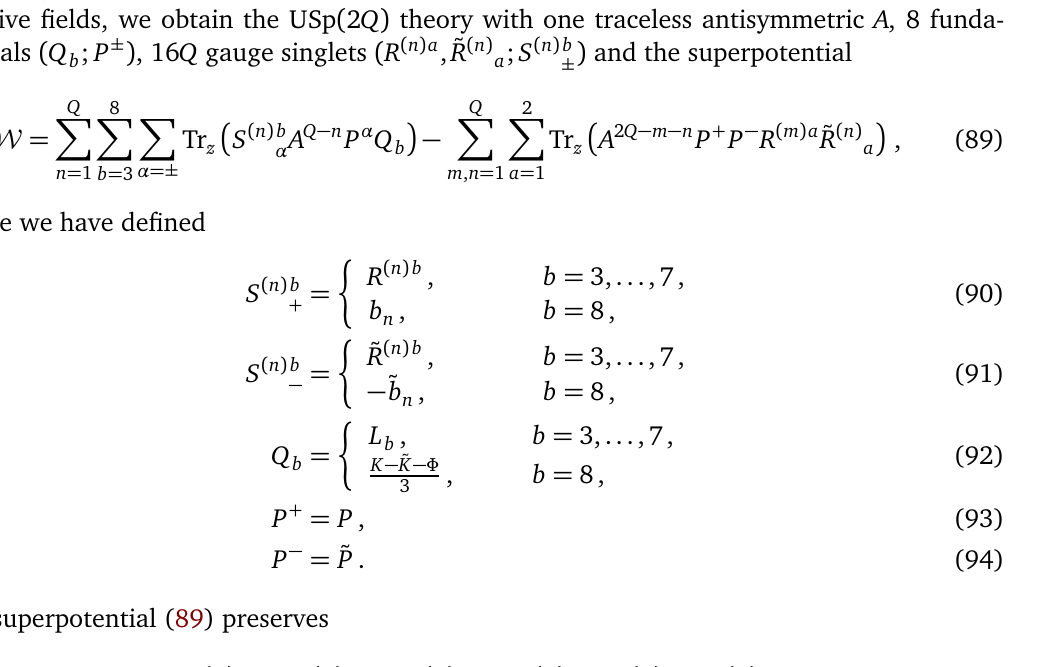
Table 3: The matter contents of the E